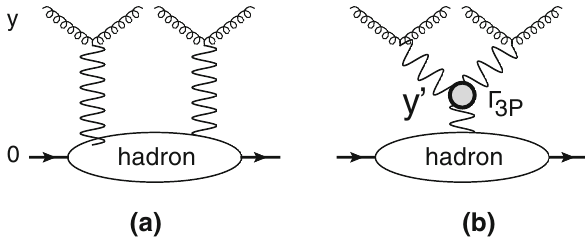
Fig. 9 Graphical illustration of the solution (B2). The diagram a with the exchange of two BFKL Pomerons (denoted by wavy lines) corre- ( 2 ) (γ ,γ ) ; the diagram b which sponds to the first term containing ˜ ρ 1 2 in includes the triple Pomeron vertex (cid:19) 3 IP corresponds to the second term ( 1 ) (γ + γ ) . Helicoidal lines denote containing ˜ ρ 1 2 in